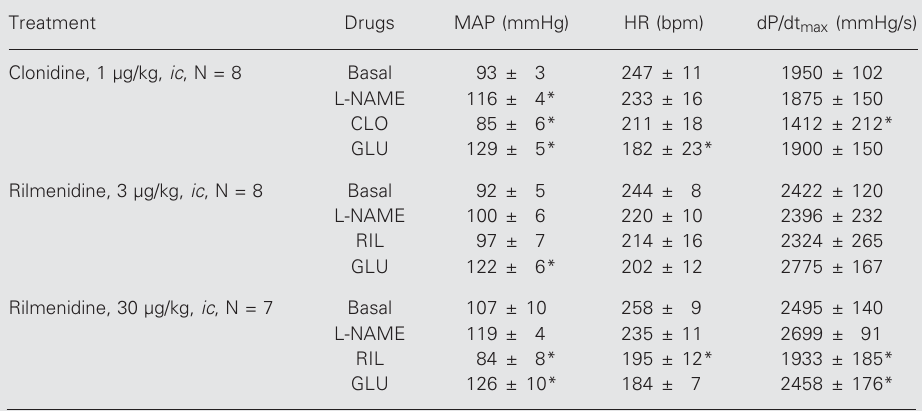
Table 3. Hemodynamic effects of intracisternal ( ic ) administration of clonidine (CLO) and rilmenidine (RIL) after N (cid:2) -nitro-L-arginine methyl ester (L-NAME, 40 mg/kg, iv ) and before L-glutamate (GLU, 10 µmol, icv ) in pentobarbital-anesthetized